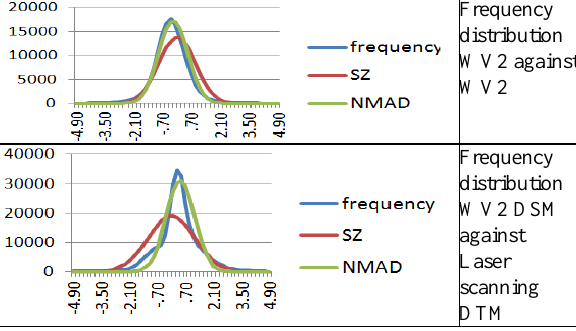
Figure 4: frequency distribution with overlaid normal distribution based on RMSZ and NMAD